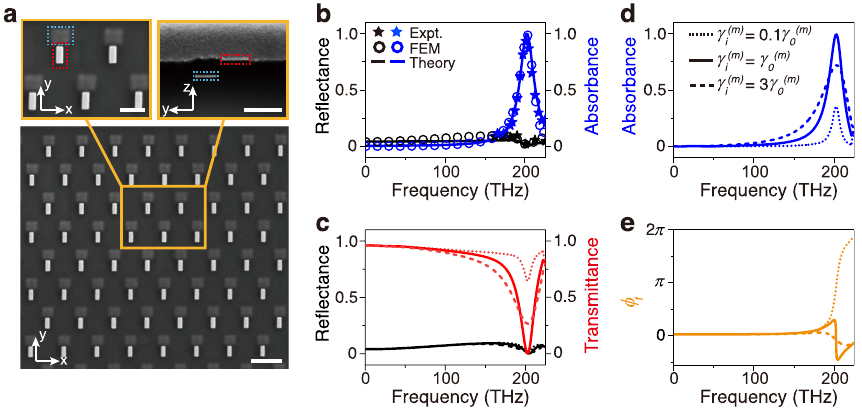
Fig. 6 Experimental/numerical characterizations on the achromatic reflectionless metasurface with tunable loss. a Top-view SEM image of sample #4 (scale bar: 1 μm) with top-left inset depicting a zoom-in top-view SEM picture (scale bar: 500 nm) and top-right inset depicting a side-view FIB-SEM picture (scale bar: 500 nm), respectively. b Spectra of reflectance and absorbance of sample #4 within the wide frequency range of 0–225 THz, obtained by experiments (stars), simulations (circles) and CMT calculations (solid lines) with parameters computed by the LEM theory, respectively. c - e FEM-simulated spectra of c reflectance/transmittance, d absorbance and e transmission phase for the sample #4, assuming that its absorption damping parameters γ ( m ) i ( m 1,2) take different values (The dotted/ solid/ dashed lines denote cases with γ ( m ) =